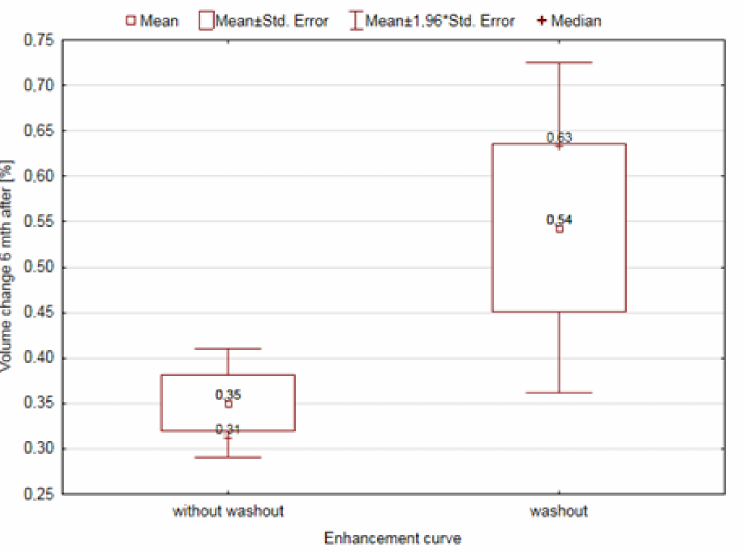
Figure 4. The effect of the distribution of the enhancement curve on the changes in tumor volume after 6